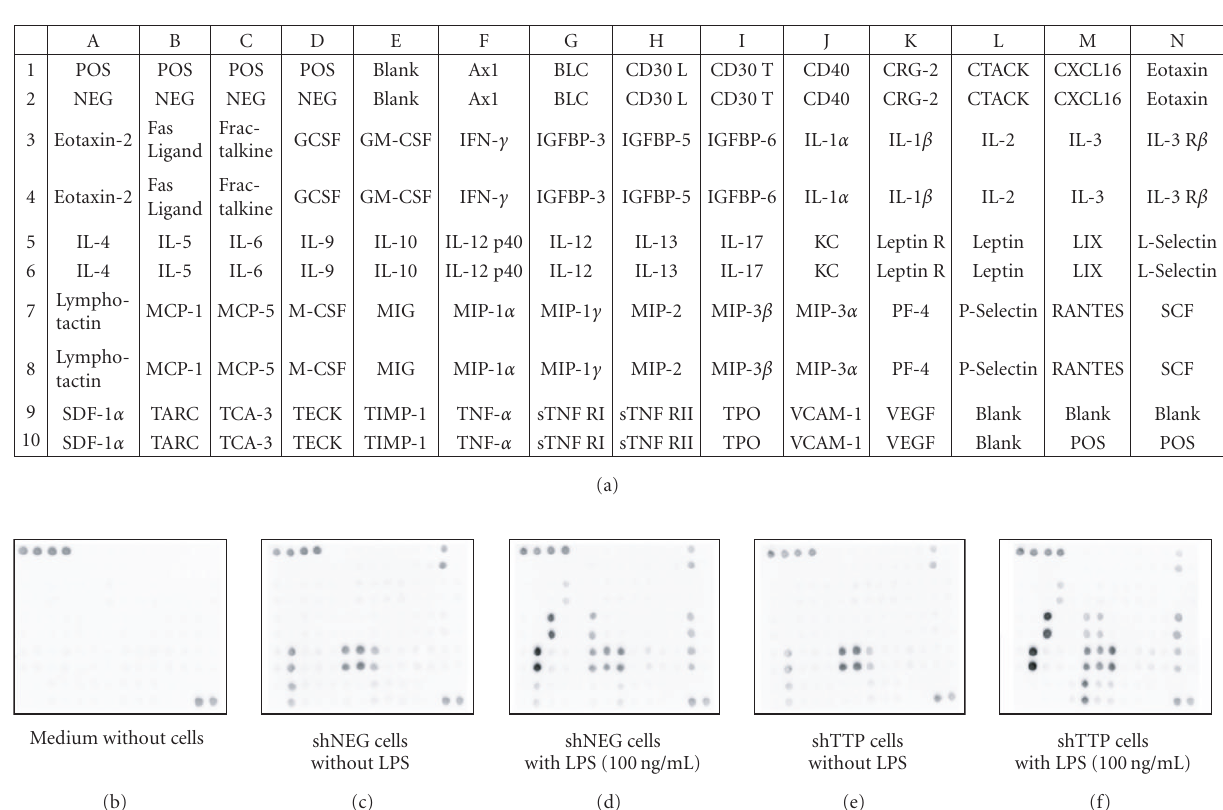
Figure 2: Cytokine antibody array. (a) A schematic diagram of the Mouse Cytokine Antibody Array III shows the locations of controls and the duplicate spots of cytokines. (b)–(f) Images of the membranes treated with cell culture media from the following experiments: (b) culture medium without cells, (c) shNEG cells, 49 h incubation, (d) shNEG cells, stimulated for 1 h with LPS (100 ng/mL) and incubated thereafter for 48 h, (e) shTTP cells, 49h incubation, (f) shTTP cells, stimulated for 1 h with LPS (100ng/mL) and incubated thereafter for 48 h. Representative membranes of three with similar results are shown. POS = positive control, NEG = negative control.